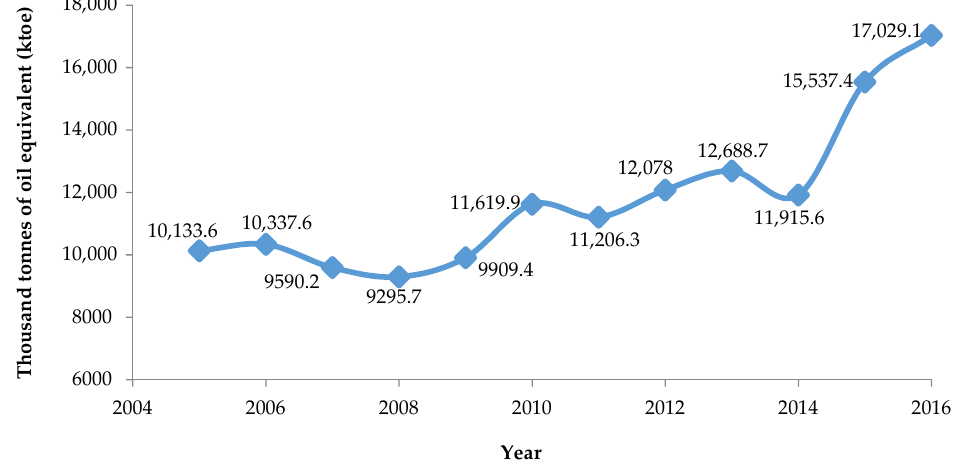
Figure 1. The graphic of primary production data from [22] by renewable energies in Turkey.